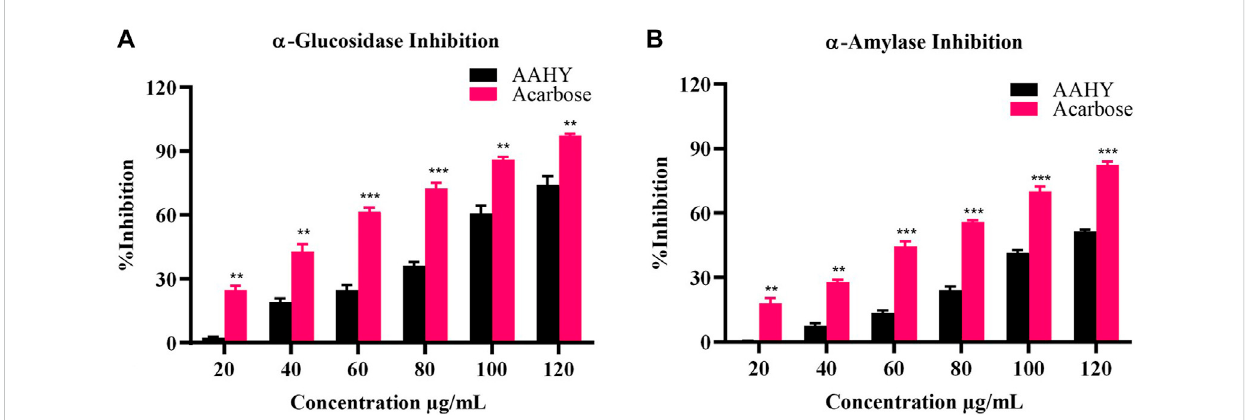
FIGURE 3 Invitro (A) α -glucosidaseand (B) α -amylaseactivitiesoftheAAHYextract.%inhibitionsareexpressedasmean±SEM,and n =3.* p < 0.05,** p < 0.01, and *** p < 0.001 versus the AAHY extract. SEM: standard error of mean.